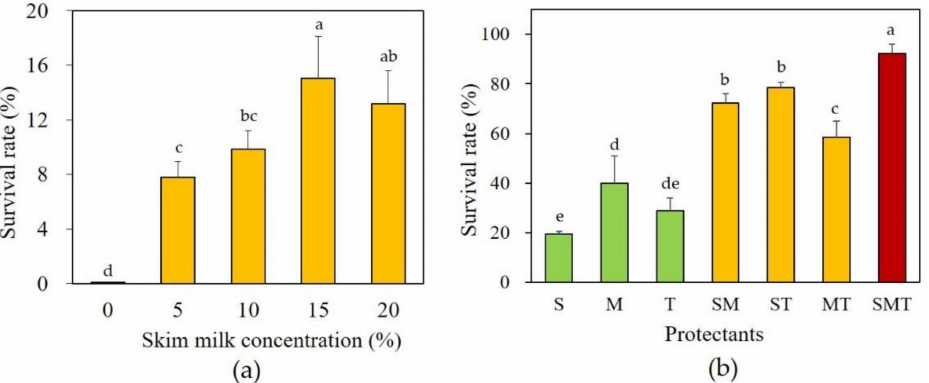
Figure 2. ( a ) Effect of skim milk concentration and ( b ) combinatorial effects of selected protectants on the survival rate of S. cerevisiae 88-4 after freeze drying. S, skim milk (15%); M, maltose (10%); T, trehalose (10%). a–e Values with different letters on the bar indicate significant differences ( p <